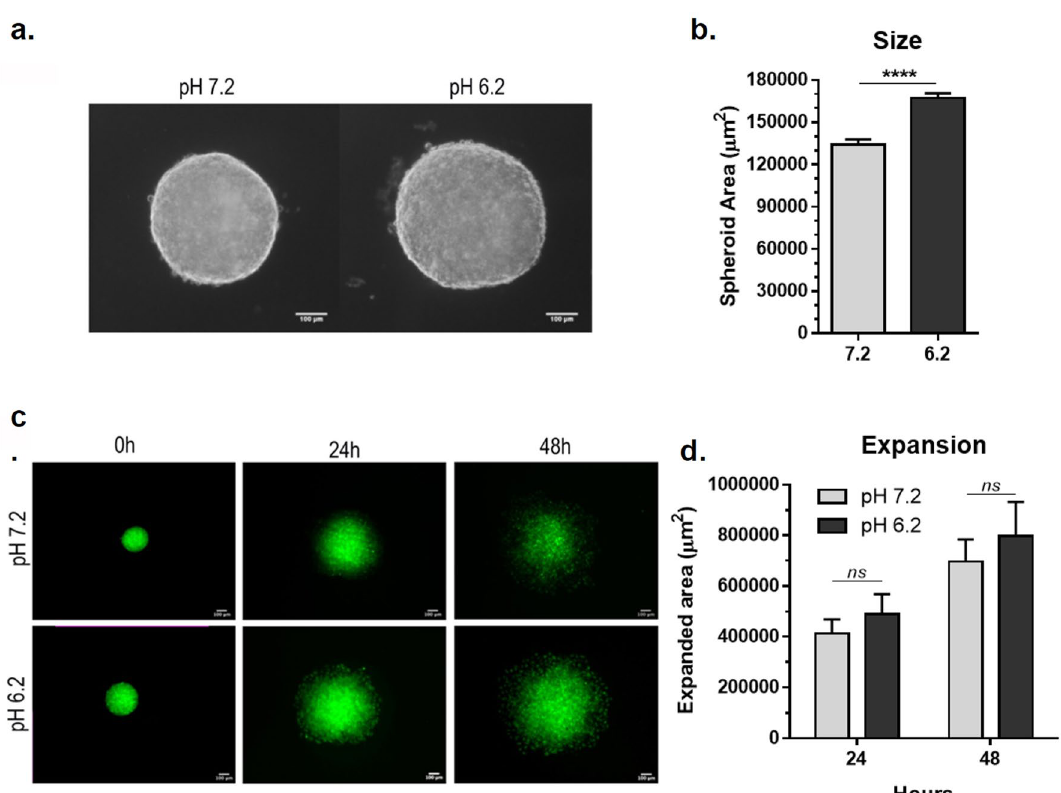
Figure 4. MCF7 mammary carcinoma spheroid expansion occurs in neutral and acidic environments. ( a ) MCF7 spheroids formed by the hanging drop method were imaged by phase-contrast microcopy after 24 h growth at pH 7.2 or 6.2 as indicated. ( b ) Spheroid area was measured and shown as µm 3 (mean + SEM, n = 10). ( c ) MCF7 spheroids labeled with Cell Tracker Green were incubated on glass coverslip coated with gelatin at pH 7.2 or 6.2 and imaged by confocal microscopy at indicated time points. ( d ) Spheroid expansion relative to the initial 0 h time point was measured and shown as µm 2 (mean + SEM, n = 5). Quadruple asterisks and ns indicate p < 0.001 and > 0.05 by t-test as